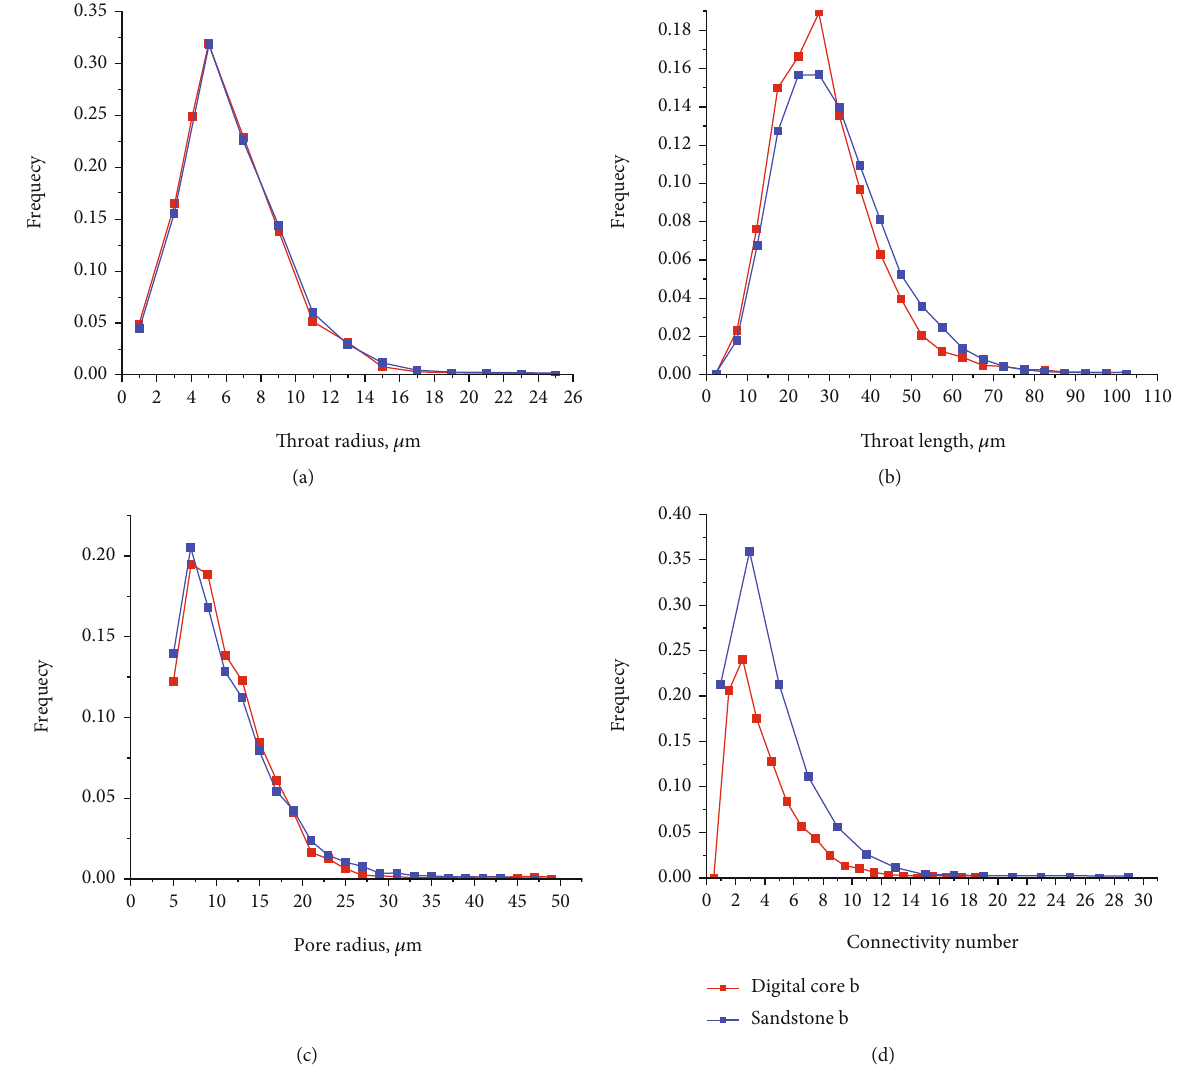
Figure 17: Pore-throat parameters of digital core b and sandstone b: (a) throat radius; (b) throat length; (c) pore radius; (d) connectivity